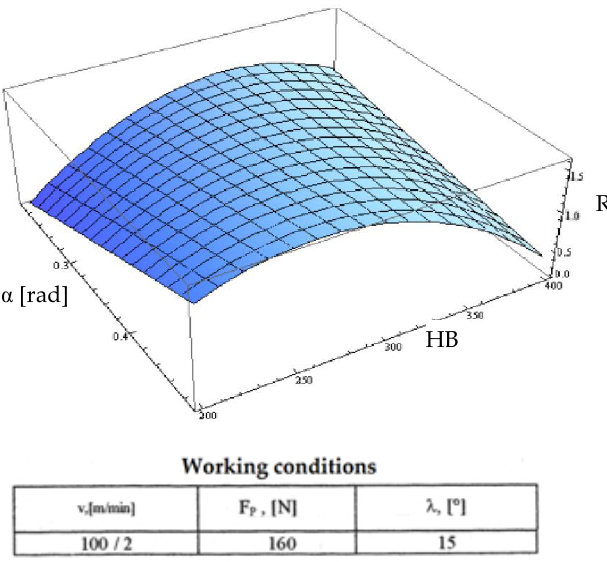
Figure 23. Influence of the clearance angle and hardness on roughness R a.